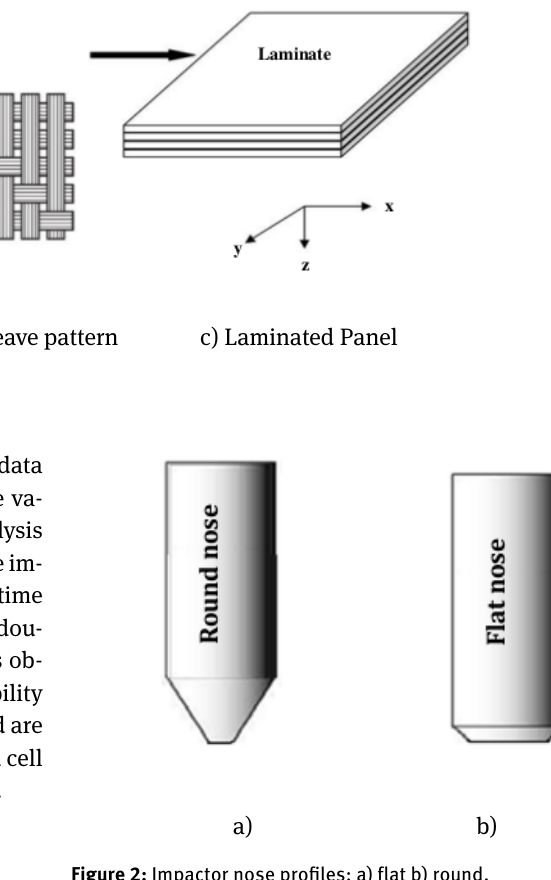
Figure 2: Impactor nose profiles: a) flat b)